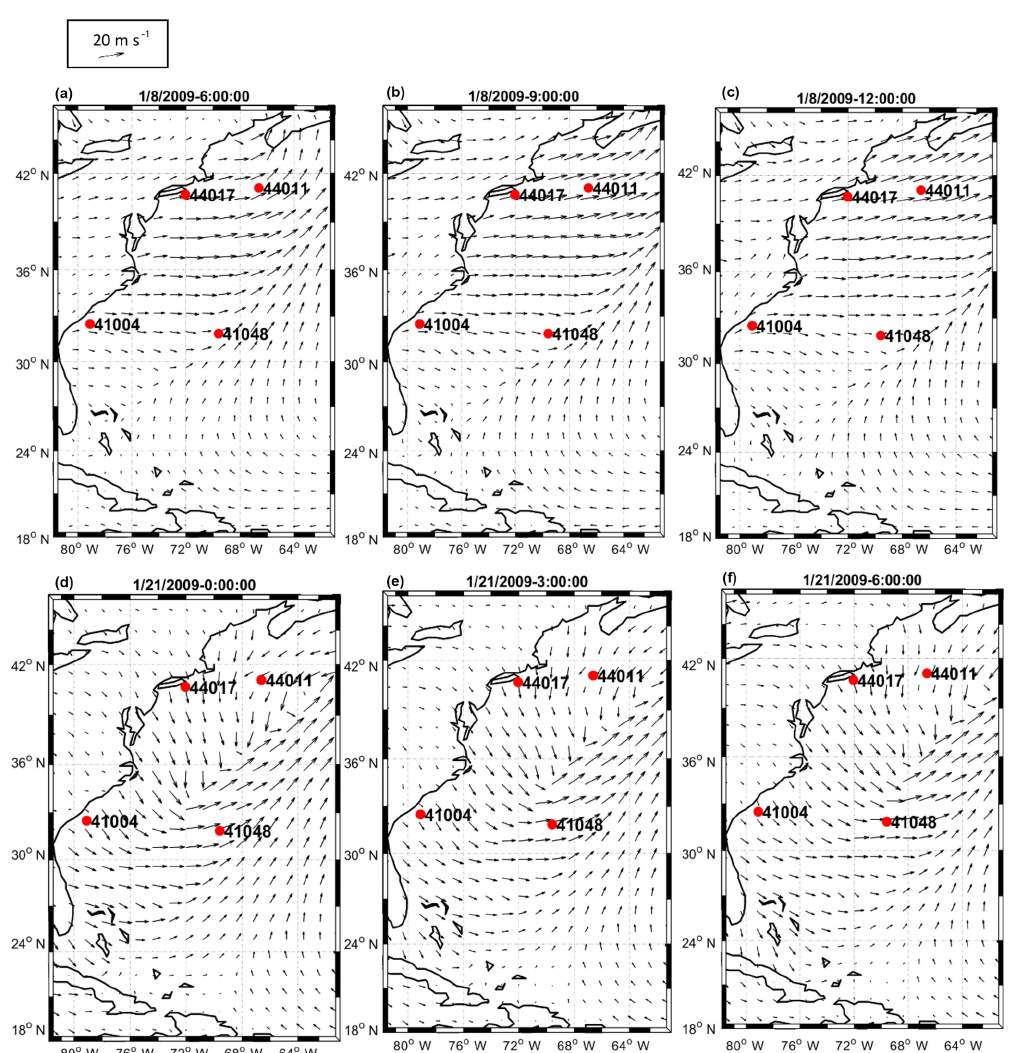
Figure 5. The 3-hourly snapshots of CFSR wind fields over the modeling area ending at times t1 (8 January 2009 12:00UTC, a–c ) and t2 (21 January 2009 06:00UTC, d–f